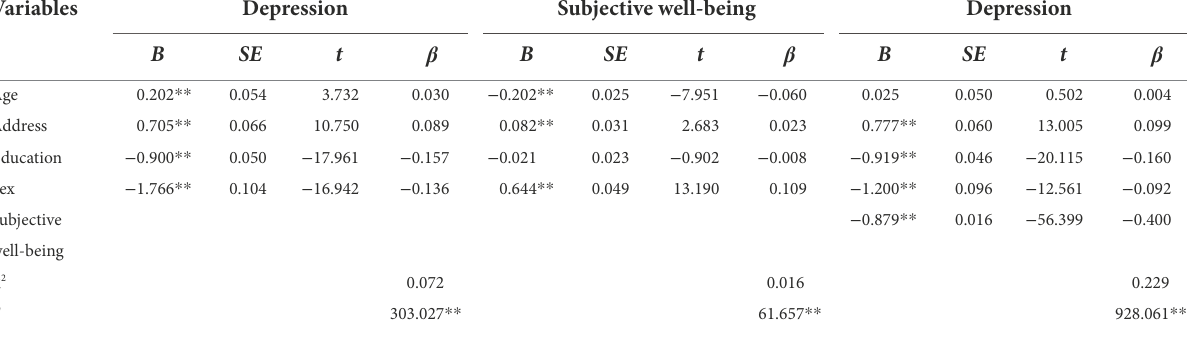
TABLE 4 The test of the mediating effect of subjective well-being between sex and depression (total and direct effects).